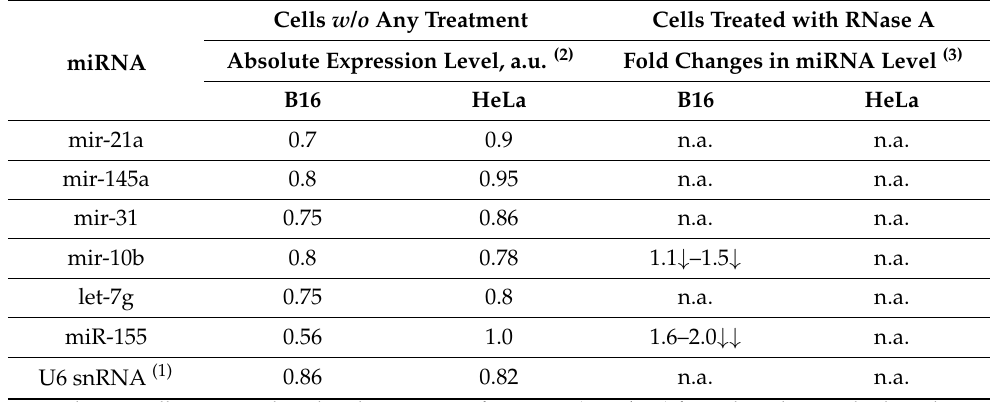
Table 1. The levels of miRNAs in B16 and HeLa cells after treatment with RNase A in vitro. Cells w/o Any Treatment Cells Treated with RNase A Absolute Expression Level, a.u. (2) Fold Changes in miRNA Level (3) miRNA B16 HeLa B16 mir-21a 0.7 mir-145a 0.8 mir-31